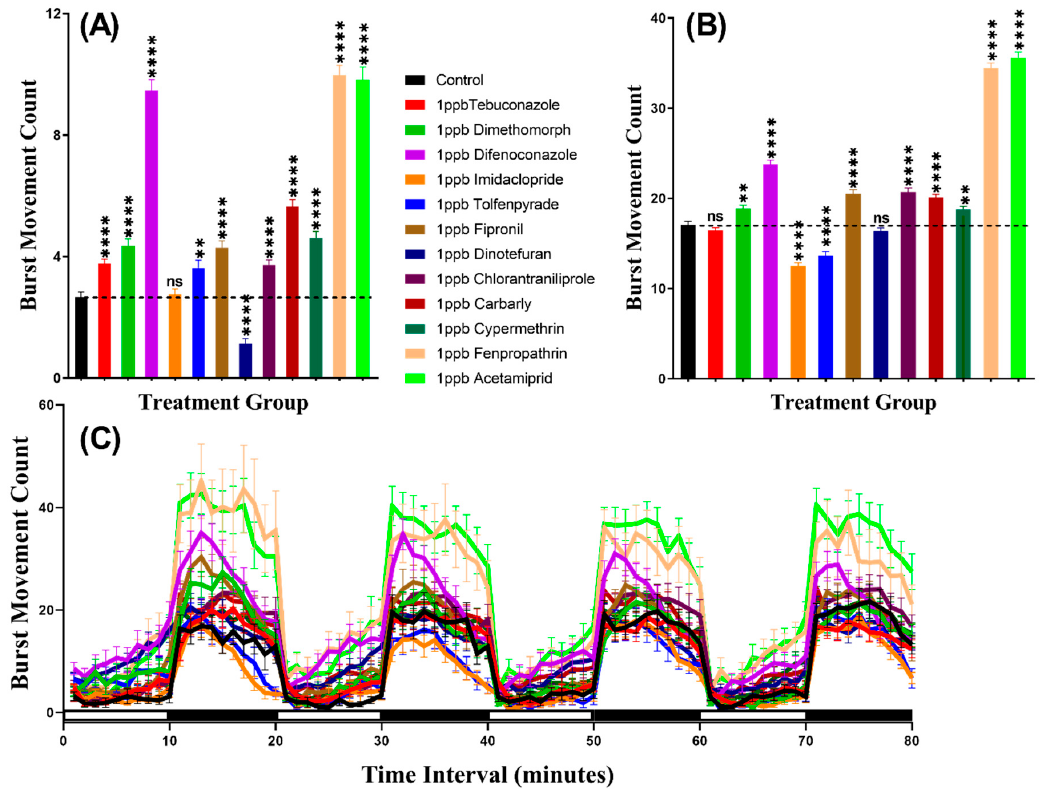
Figure 3. Total burst count of control and 1 ppb pesticides treated zebrafish larvae after a 24-h exposure. ( A ) The total number of bursts observed during the light cycle. ( B ) The total number of bursts observed during the dark cycle. ( C ) The pattern of burst count during light / dark transition. The data are expressed as the Mean ± SEM and they were analyzed by Two-way and Brown–Forthsythe and Welch ANOVA test. Dunnett’s multiple comparison test for comparing all treatments with control was carried out to observe the pesticide e ff ects ( n = 24; ns = not significant, ** p < 0.01, **** p < 0.0001).